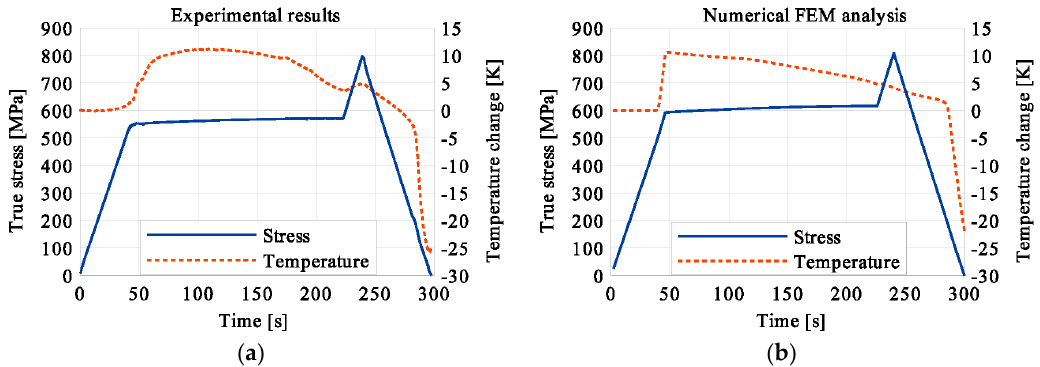
Figure 9. Stress and temperature variations vs. time for the loading program (2): 3-min loading interruption in the middle of the LMT: ( a ) experimental; ( b ) numerical results.